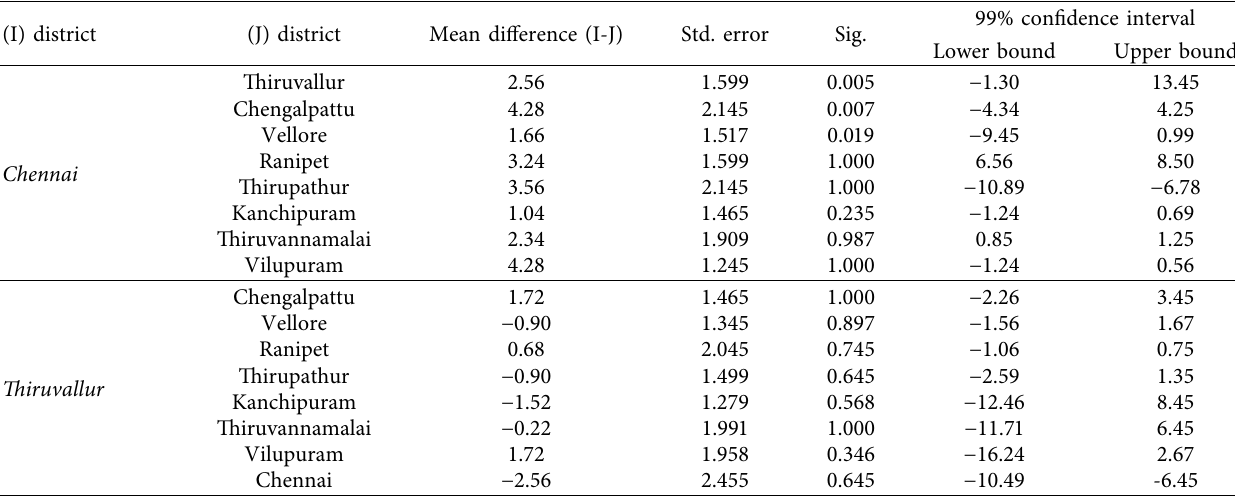
Table 5: Personality development scores of students: district wise comparison Tukey HSD, dependent variable: leadership